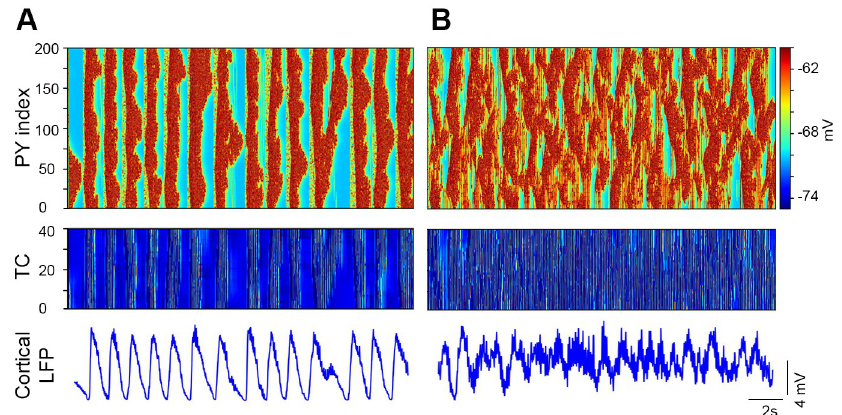
Fig 6. The influence of fast spindles in the SO cycle. A , The control simulation in which the fast spindles are coupled with SO-first-half and slow spindles with the SO-second-half. Cortical and network exhibit regular LFP and both the up and down states of SOs are quite clear. B , The simulation in which fast spindles were coupled with both phases of the SO cycle, the first half and the second half. Top panel: PY raster plot revealing that fast spindle coupling in the second phase almost diminished the down/hyperpolarized state of SO. Middle and bottom panels: Fast thalamic activity in both SO halves produced irregular (middle) and more depolarized (bottom) responses.